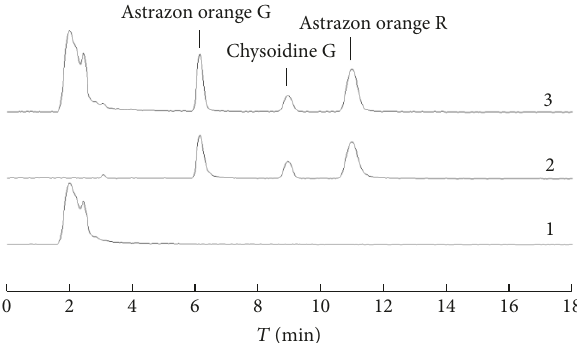
Figure 7: Chromatograms of the red hot chili peppers (curve 1), the standard of three dyes (each 2 𝜇 g/mL, curve 2), and the red hot chili peppers spiked standard solution (each 2.5 𝜇 g/mL, curve